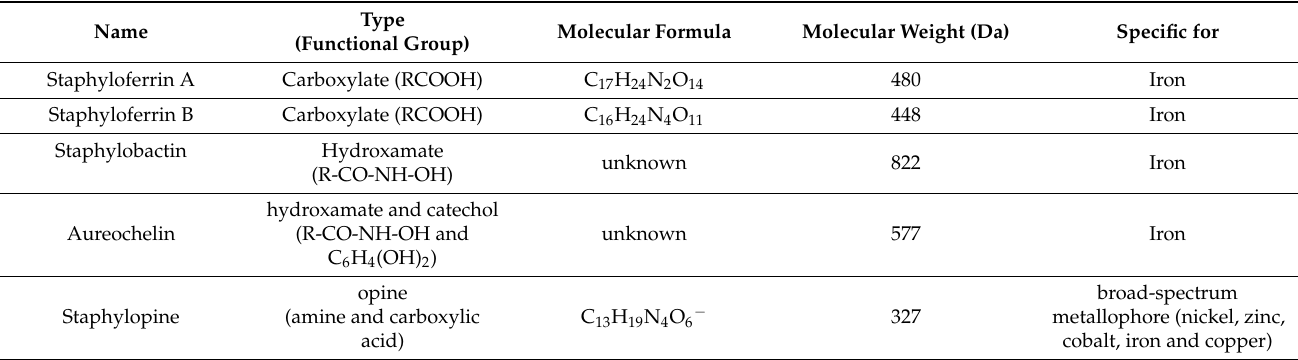
Table 1. Different types of metallophores produced by S. aureus .